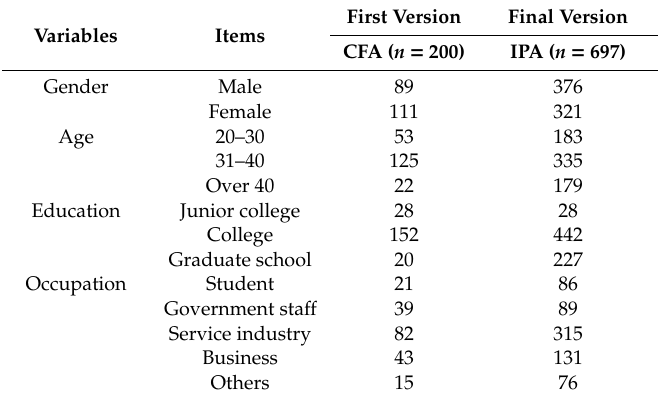
Table 5. Participant characteristics for FSG-scale.